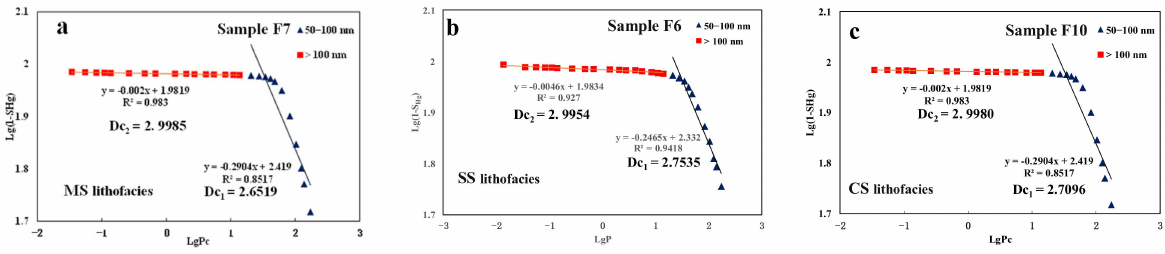
Figure 8. Fractal dimension curves calculated based on MIP data: ( a ) MS lithofacies; ( b ) SS lithofacies; ( c ) CS